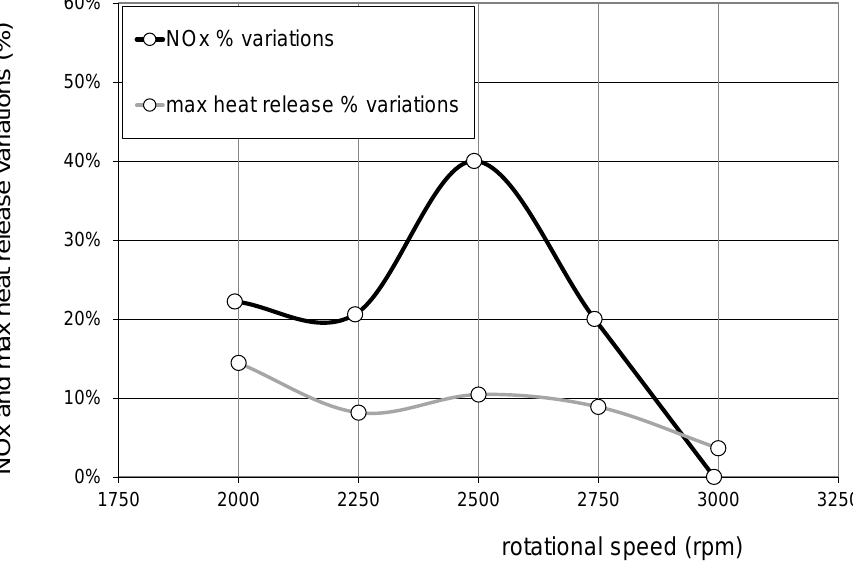
Figure 6. NO x emissions and heat release peak variations for the biodiesel at full load as a function of the rotational speed (ref. diesel fueling).